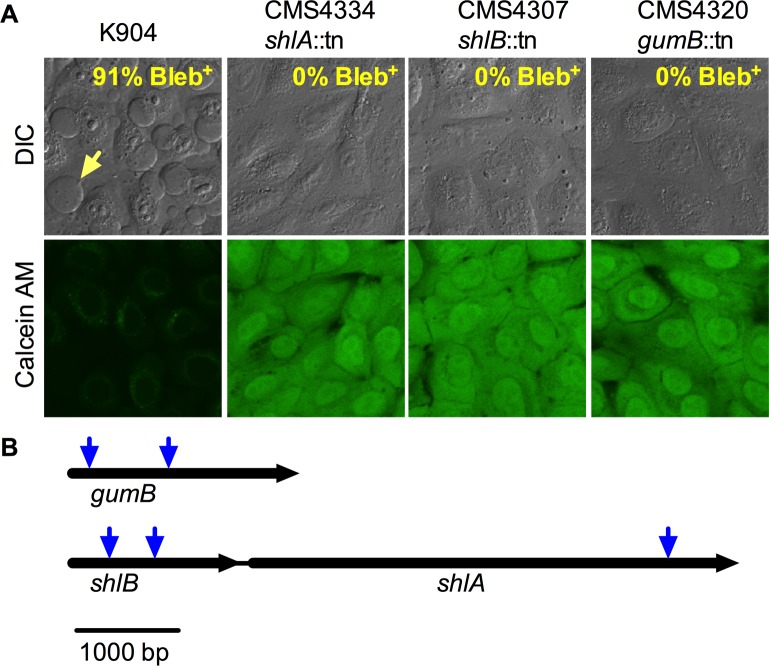
S. marcescens mutations that abrogate cytotoxicity in HCLE cells were isolated and mapped.(A) Confocal micrographs of primary human corneal epithelial cells challenged with S. marcescens strain K904 wild type and mutant strains isolated for being unable to induce bleb formation (MOI = 200 for 2 h). Three of five mutants are shown, with the other two having an indistinguishable effect on the corneal cells. Differential interference contrast (DIC) and calcein AM viability stained images are shown. (B) Genetic context of transposon insertion mutations that render S. marcescens unable to induce bleb formation in corneal epithelial cells. Downward facing blue arrows indicate transposon insertion sites. Size bar indicates 1000 base pairs.